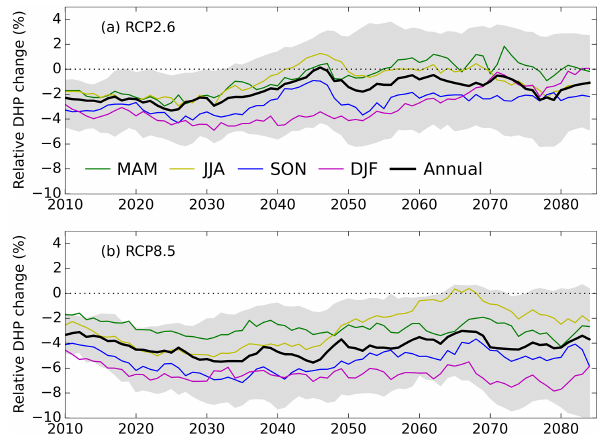
Figure 5. Medians of relative changes in the DHPs of present reser- voirs in China over the 2010–2084 period under RCP2.6 (a) and RCP8.5 (b) . Solid lines show the ensemble medians of DHP; grey areas denote the IQRs of the annual DHPs. All of the annual and seasonal time series of the DHPs are estimated at a 31-year moving average over 1971–2099 and are labeled with the center